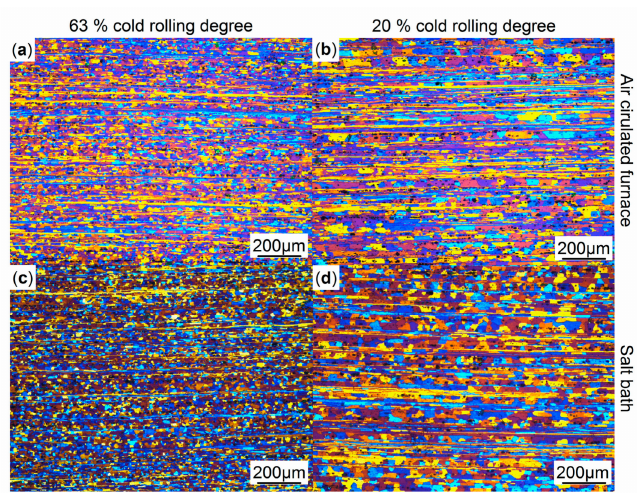
Figure A1. Light optical micrographs of the Zr-bearing alloy variation for 63% (left column; a , c ) and 20% (right column, b , d ) cold rolling and soft annealing in an air-circulated furnace ( a , b ) and in a salt bath with subsequent water quenching ( c , d ). Please note the di ff erent scale for the air-circulated furnace heat treatment at the 20% cold-rolling